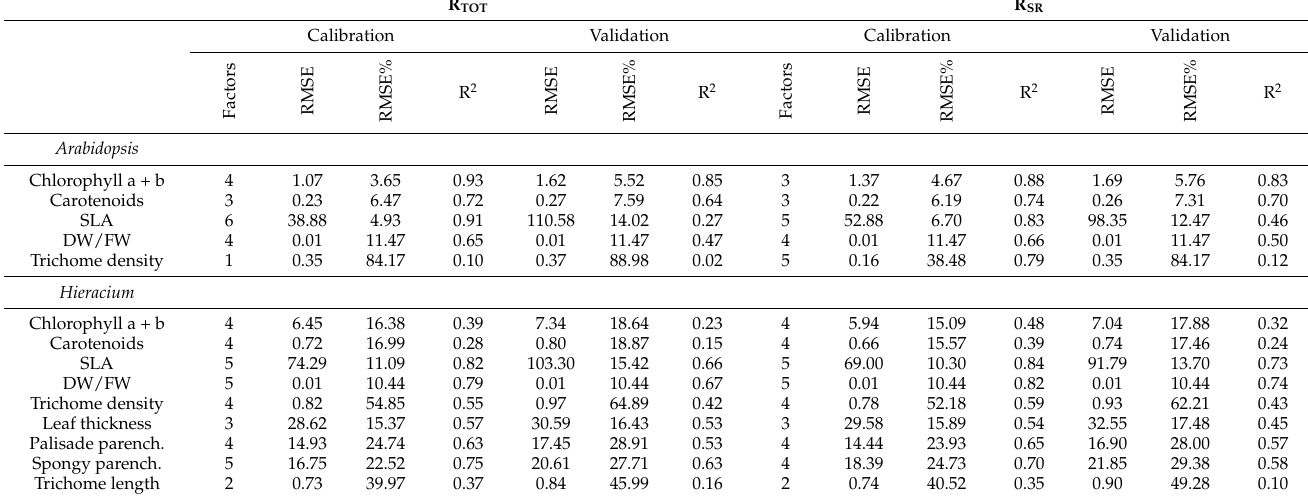
Table 3. Parameters of calibration and validation of PLSR models based on R TOT and R SR spectra between 450–1800 nm, for A. thaliana mutants and Hieracium sp. for biophysical traits. Left side of the table represents calibration and validation of PLSR models based on R TOT spectra and right side of the table represents models based on R SR . Columns represent: Factors (number of components used in model creation), RMSE (root mean square error), RMSE% (% of RMSE related to average values of parameters), R2 (Coefficient of determination) of calibration and validation of